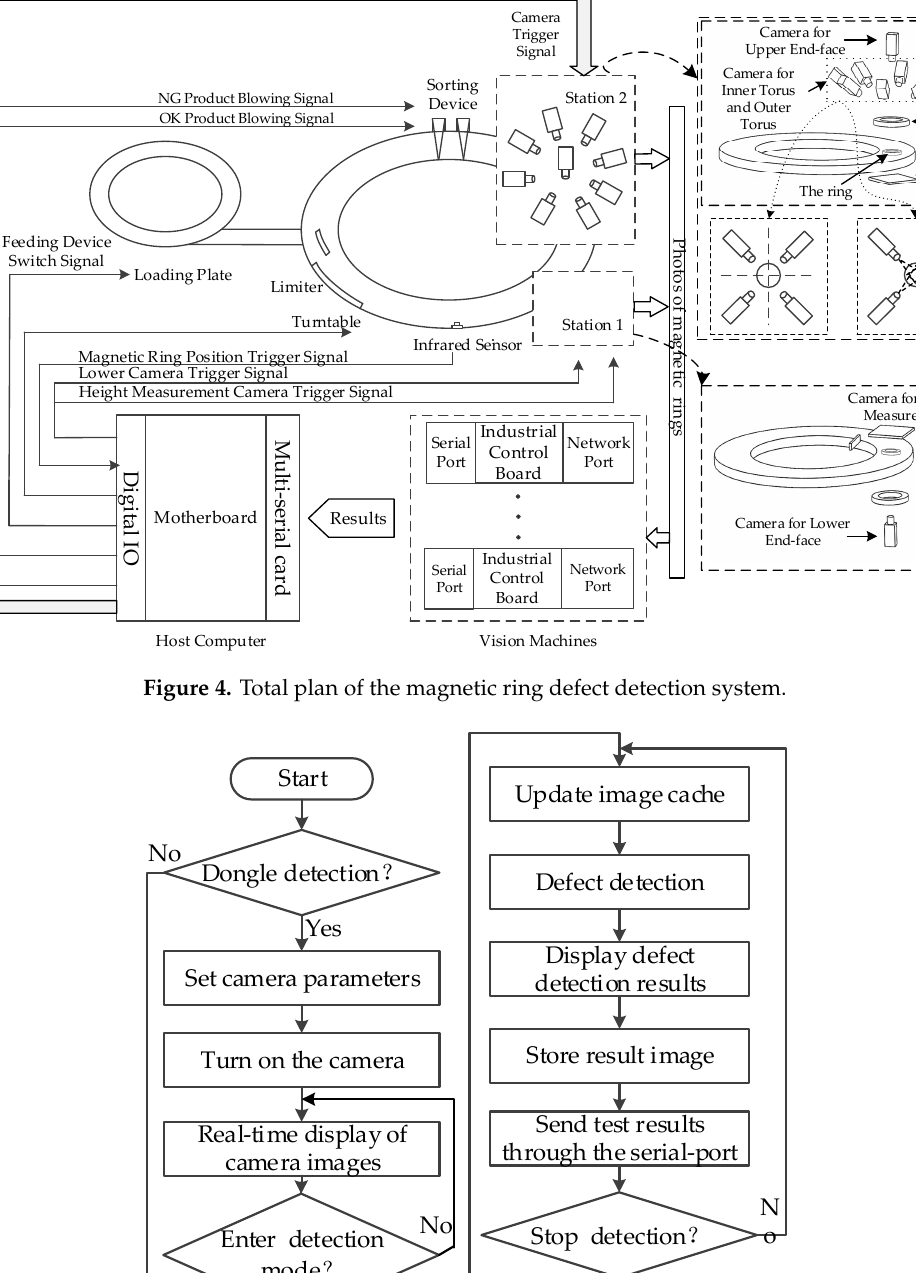
Figure 6. Magnetic ring detection program interface for No. 1 vision machine and No. 2 vision machine. 3. Methods